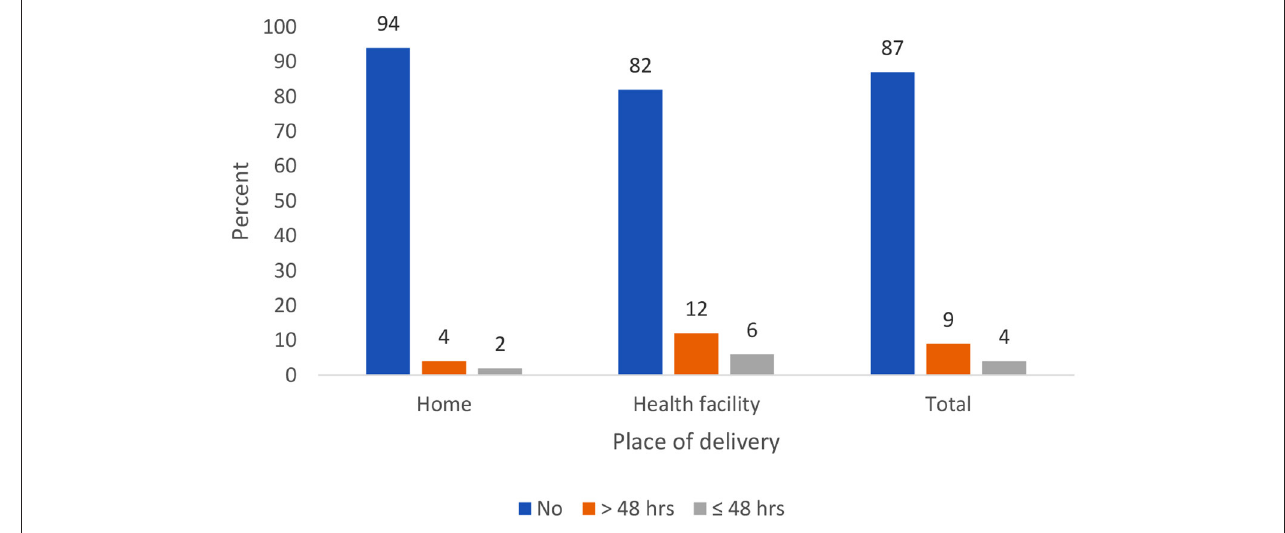
FIGURE 2 | Percent distribution of newborns by timing of the first postnatal